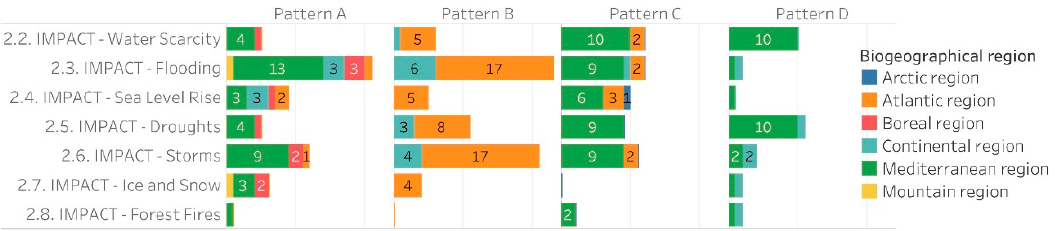
Figure 7. Distribution of initiatives according to Climate Impacts in the different biogeographical regions for each of the patterns. Source: Compiled by the authors.